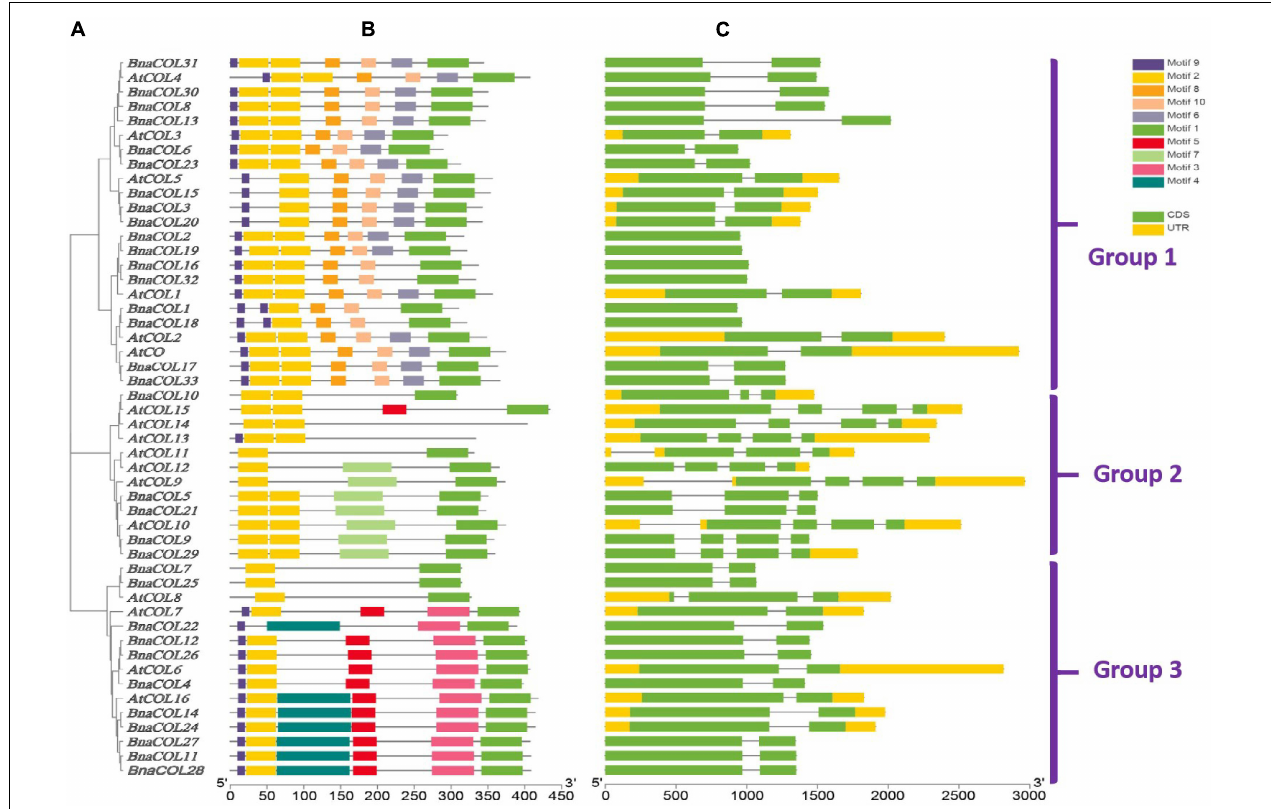
FIGURE 3 | Comparative analysis for conserved domain and gene structure between AtCOL genes and BnaCOL genes. (A) The phylogenetic analysis of 17 AtCOL genes and 33 BnaCOL genes divided them into three groups: 1, 2, and 3. (B) The conserved domains of AtCOL and BnaCOL proteins. Schematic representation of the 10 conserved motifs in BnaCOL proteins, different colored boxes represent different motifs. (C) The gene structure of AtCOL and BnaCOL genes. The green box represents exons, the yellow box represents UTR and the black line represents introns.